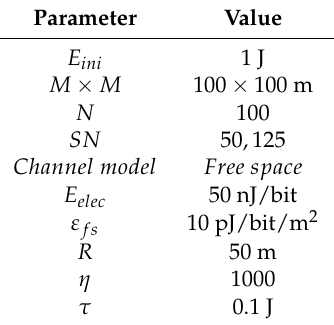
Table 3. The setting of